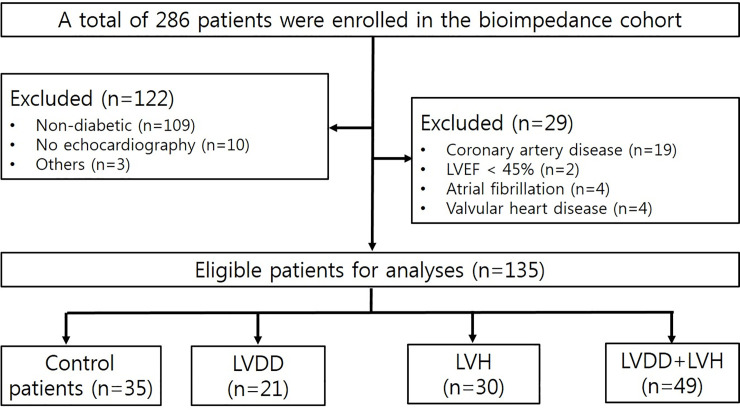
Flow diagram of patient selection in this study.